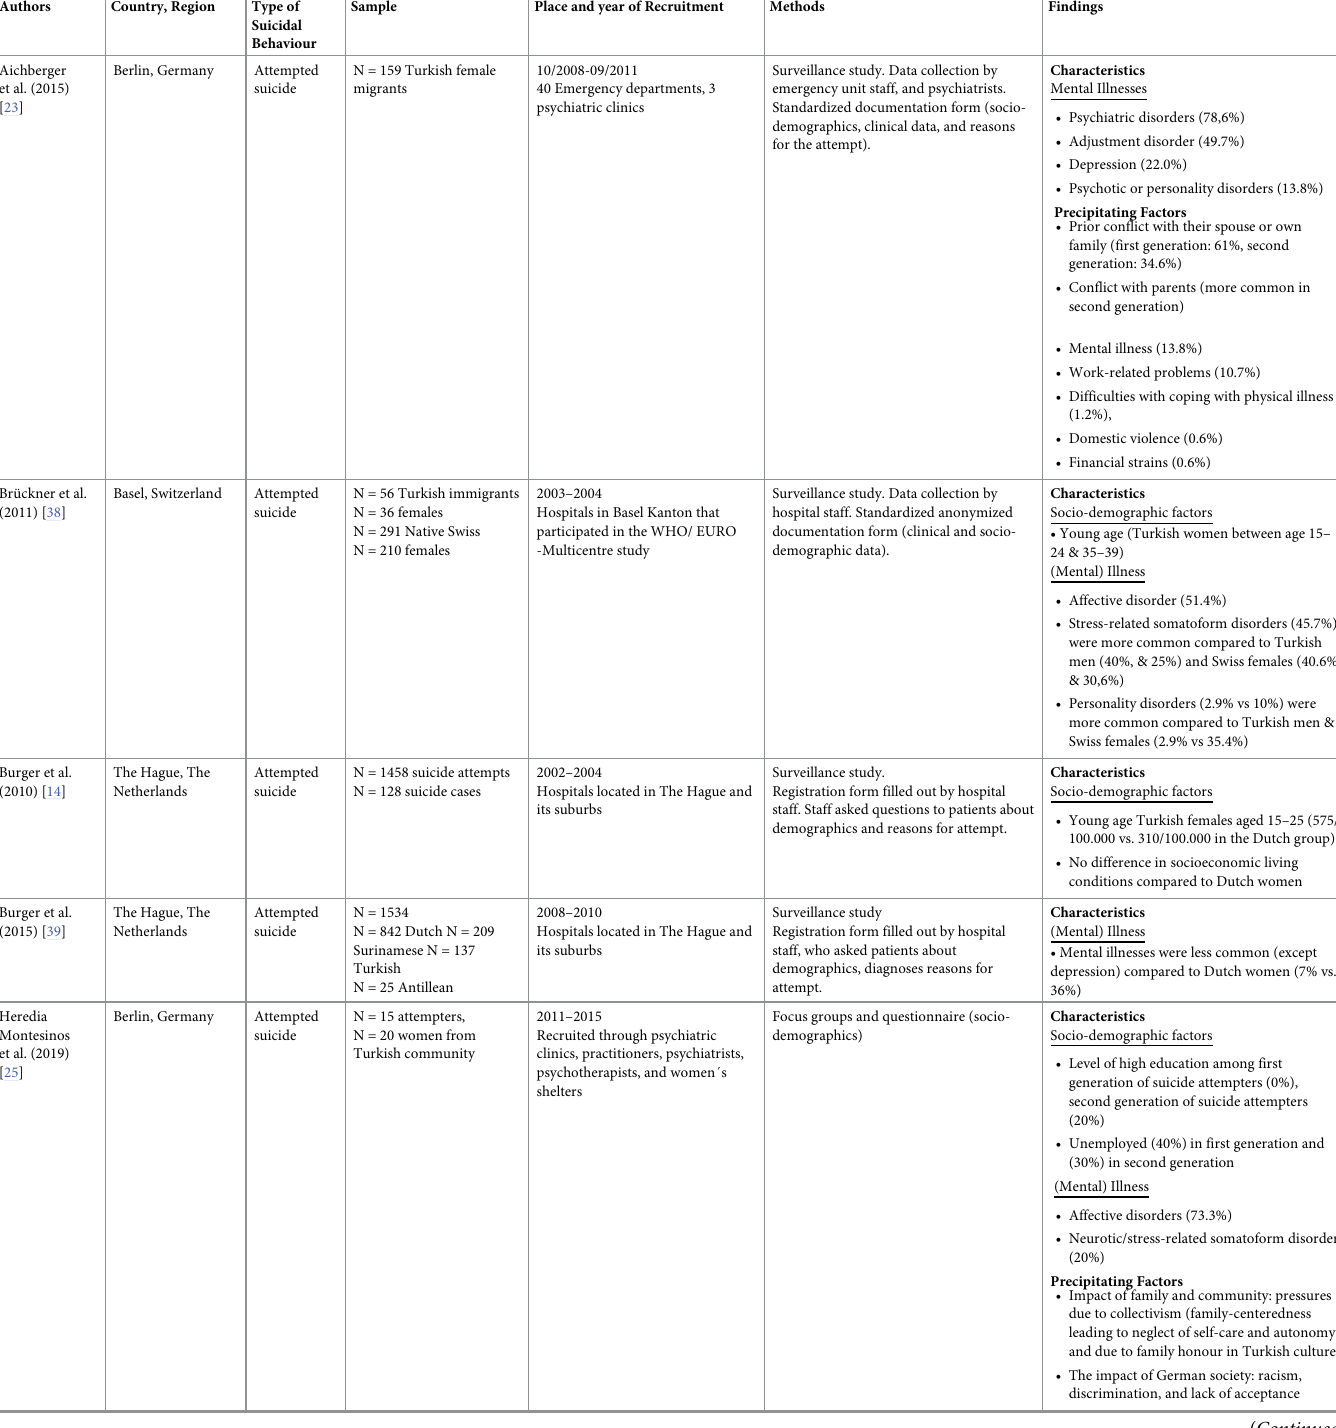
Table 2. Characteristics and precipitating factors of attempted suicide and suicide of Turkish women in Turkey and